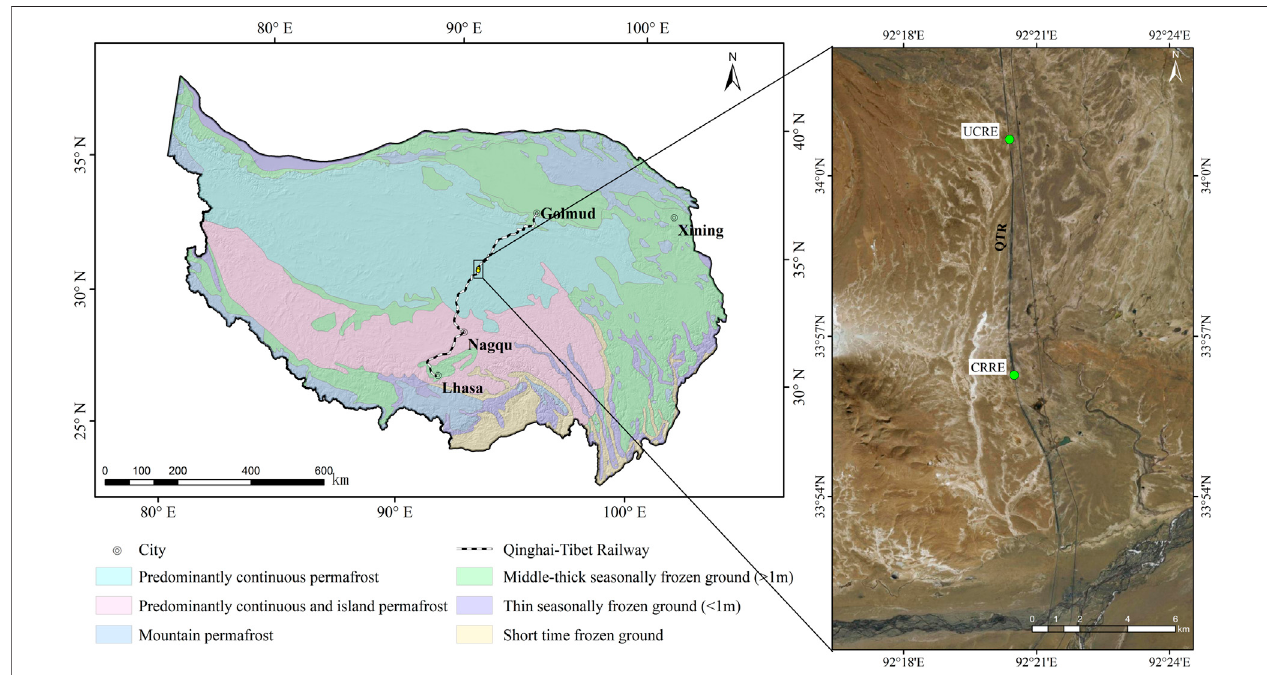
FIGURE 1 | Location of the study sites along the Qinghai-Tibet Railway.